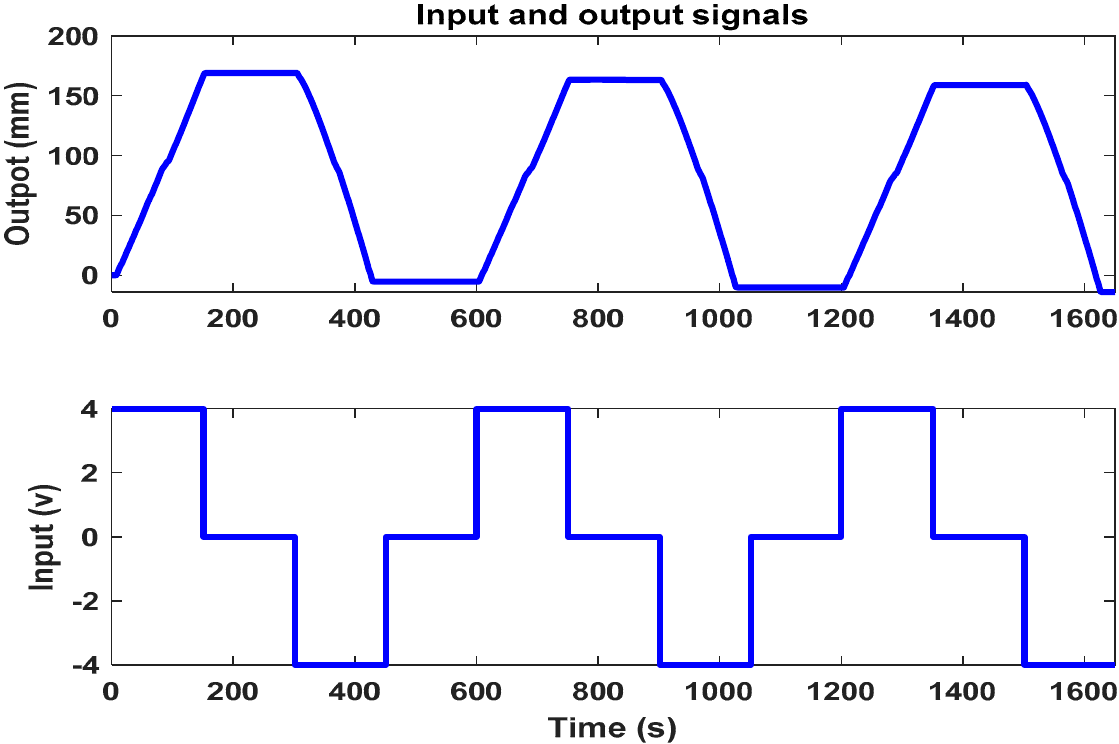
Figure 3. The measured input and output data of the system. To characterize the dynamic behavior and properties of the IPA system, a parametric model with autoregressive with exogenous input (ARX) was used as the model